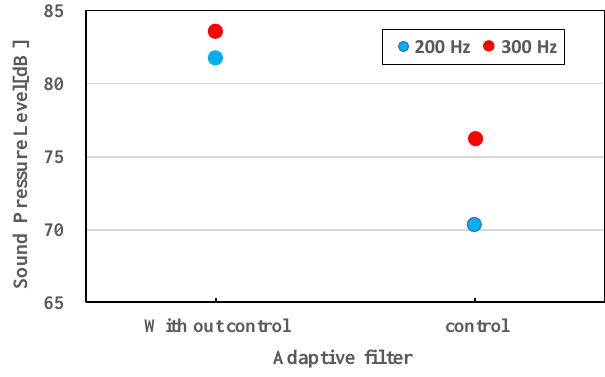
Figure 11. Experimental result of adaptive filter.